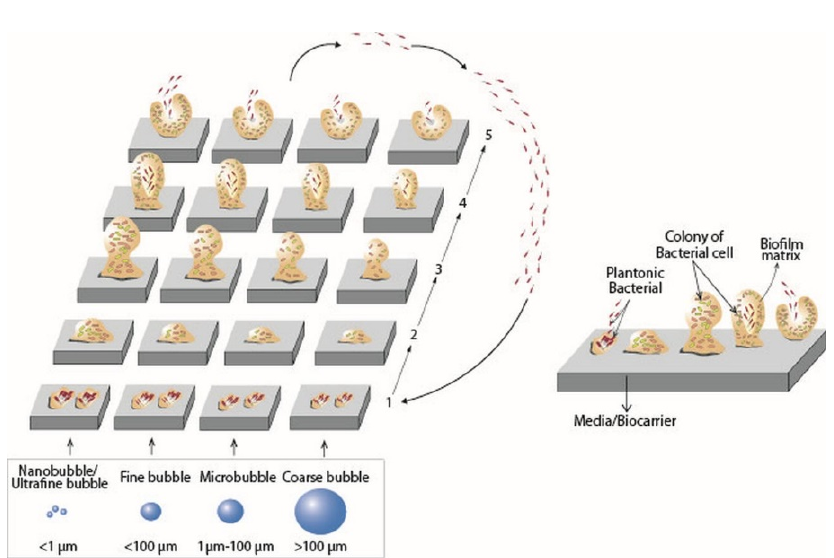
Figure 4. Effect of bubble size on the phase of biofilm growth: (1) Adhesion stage, (2) Extracellular Polymeric Substance (EPS) production, maturation stage, (3) formation of complex structure, (4) strong-adherence bacterial stage, and (5) cell detachment from the biofilm.